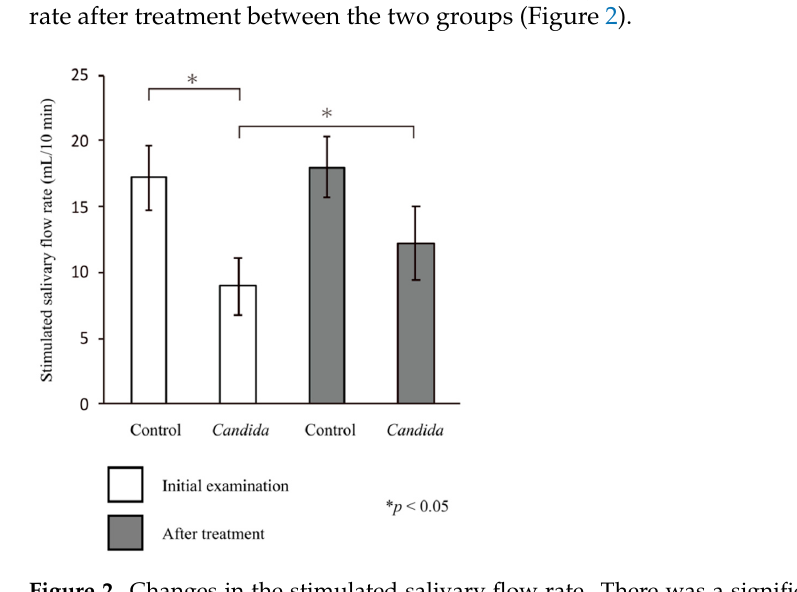
Figure 2. Changes in the stimulated salivary flow rate. There was a significant difference in the changes to the stimulated salivary flow rate at the initial visit between the control and Candida groups ( p < 0.05). In the Candida group, the stimulated salivary flow rate after prosthetic treatment increased significantly ( p < 0.05).